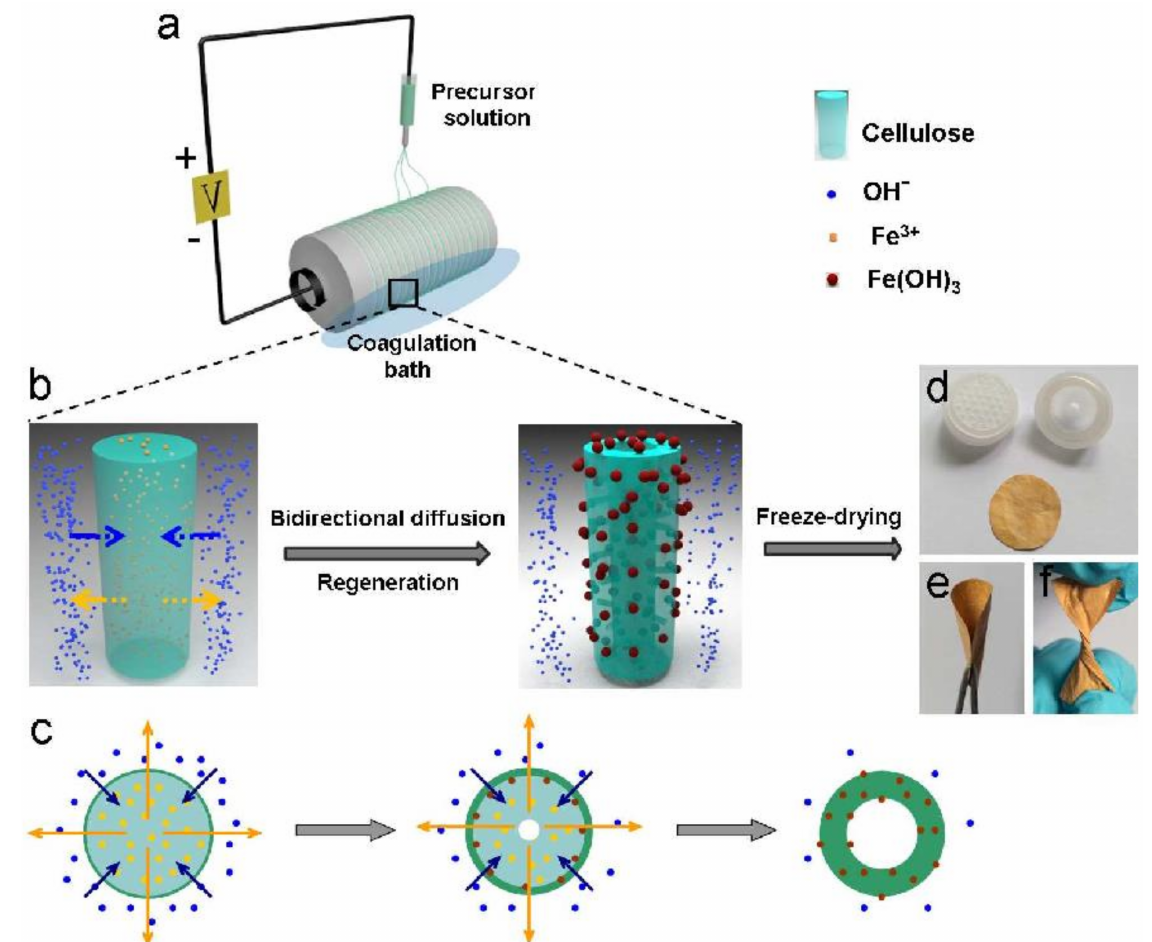
Figure 11. Electrospinning with suitable solvent systems was used to fabricate hybrid nanocellulose fibers with solid or hollow core and deposition of Fe(OH) 3 /cellulose nanoparticles: ( a ) Schematic representation of the electrospinning process for nanofiber fabrication; ( b , c ) Schematic representation of the hollow fibers as membranes for diffusion and regeneration, respectively; ( d – f ) Photographs of the Fe(OH) 3 @Cellulose HNFs membranes and the dead-end filtration device, [223] ©American Chemical Society,